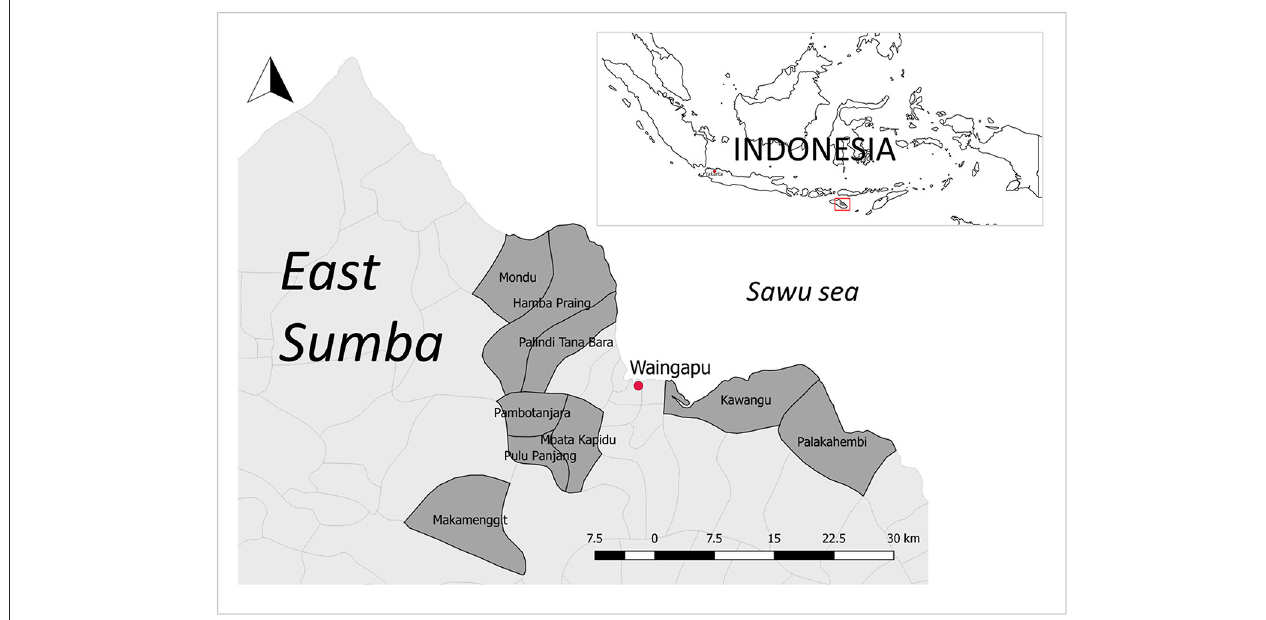
FIGURE 1 | Location of nine villages visited in district East Sumba, Indonesia; drawn using QGIS (QGIS Development Team, 2017).